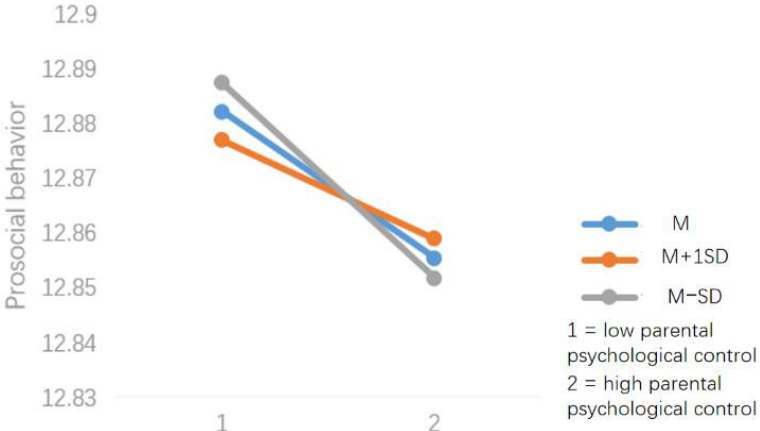
Figure 2. Simple slope test.